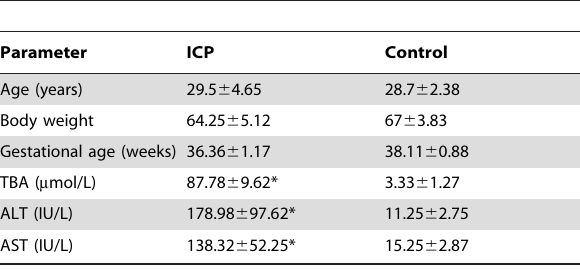
Table 1. The clinical characteristics of pregnant women with ICP and healthy pregnant